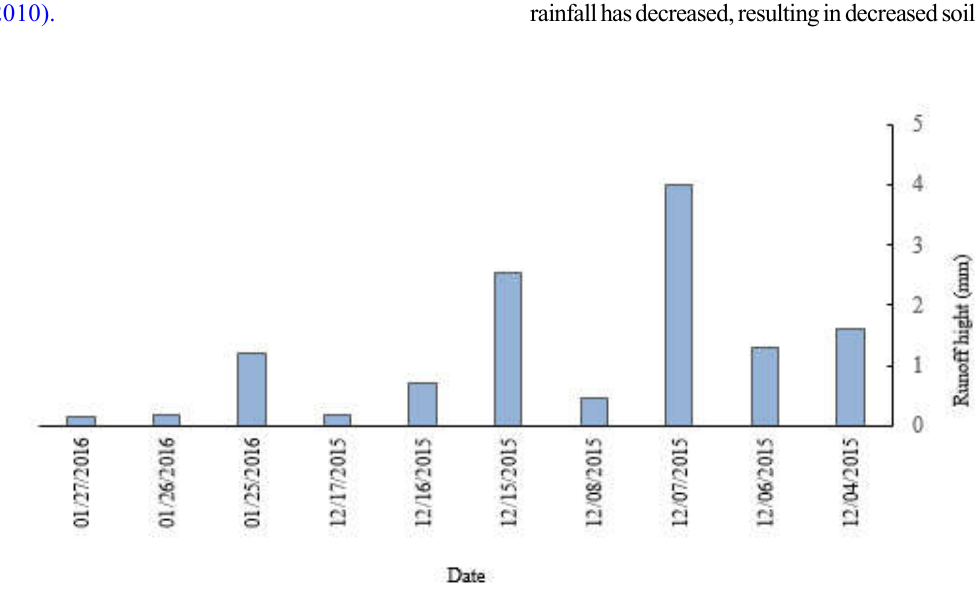
Fig. 5: Height of the collected runoff in some rainfall events